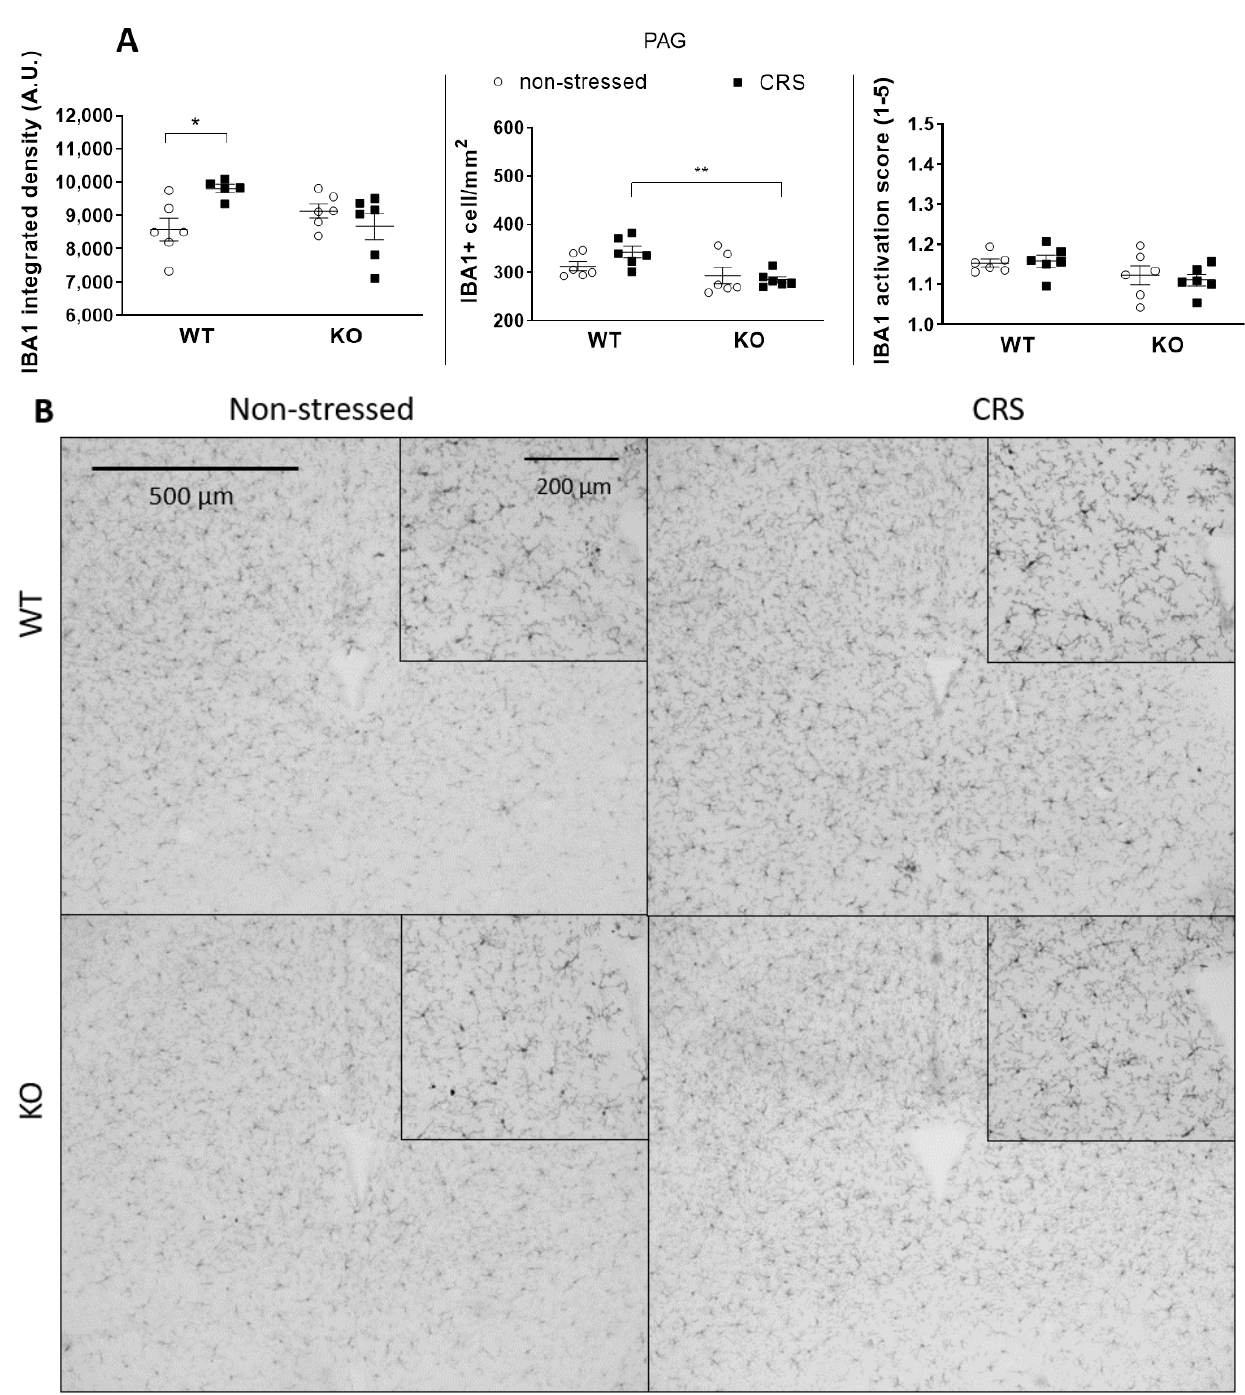
Figure 9. Diagrams show the Ionized calcium-binding adaptor molecule 1 (IBA1) integrated density, the number of IBA1+ cells and the IBA1 activation score of microglia examined in the Central Amyg- dala (CeA—( A )). Representative images show the IBA1+ microglia cells in CeA ( B ). Chronic re- straint stress (CRS), Wild-type (WT), Interleukine-1 knock-out (KO). Data are presented as the means ± SEM of n = 5–7 animals with individual plots; two-way analysis of variance (ANOVA), followed by Tukey’s tests; ** p < 0.01 vs. respective group.